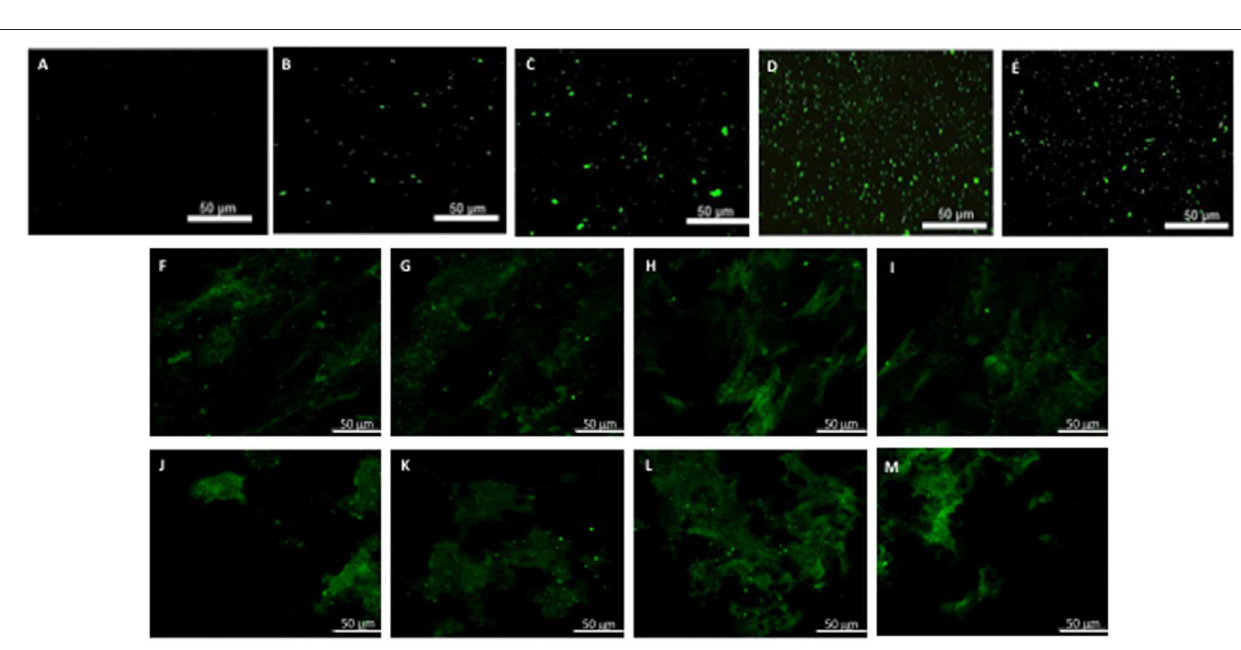
Frontiers in Cardiovascular Medicine |